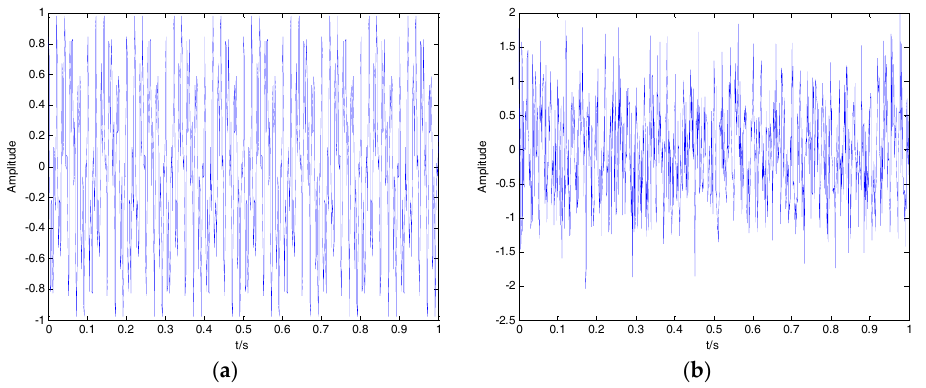
Figure 7. The time-domain waveform for the clear signal and noisy signal. ( a ) The clear signal; ( b ) the noisy signal. Table 5. The SNR and RMSE for EMD, EEMD, VMD and 2VMD denoising. Noisy